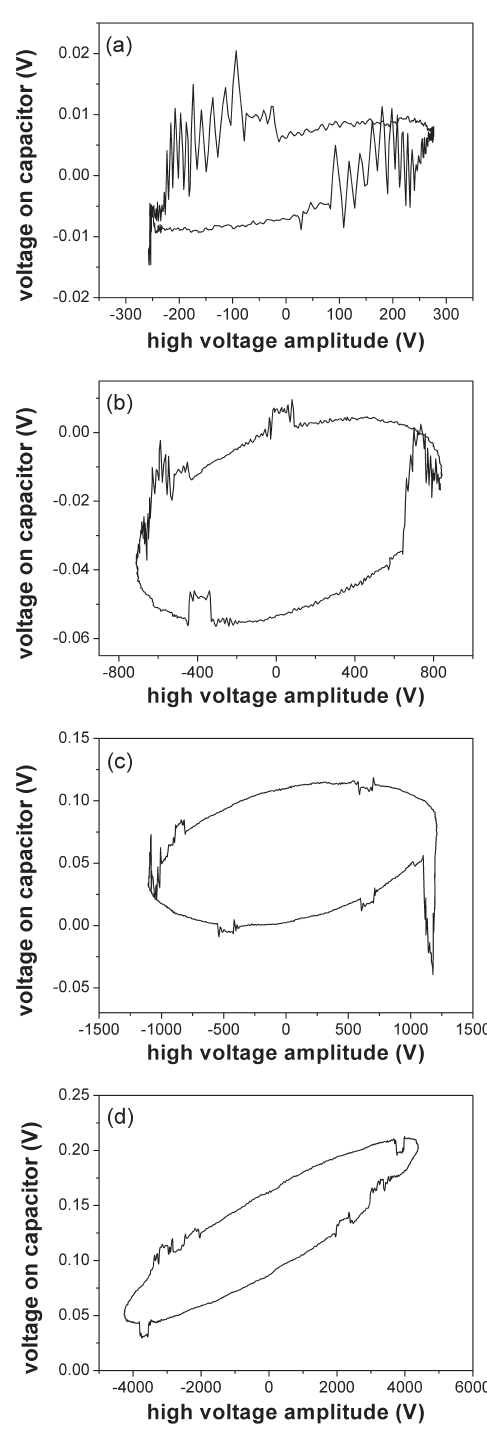
Figure 2: Lissajous charts for four processes occurring in the pin-hole reactor with the increasing applied voltage: a) electrolysis (frequency of 50.5 kHz), b) bubble formation (30.2 kHz), c) discharge operation (22.0 kHz), d) maximal discharge operation (20.8 kHz); NaCl solution (500 µS cm −1 ), dielectric barrier thickness of 0.6 mm, pin-hole diameter of 0.6